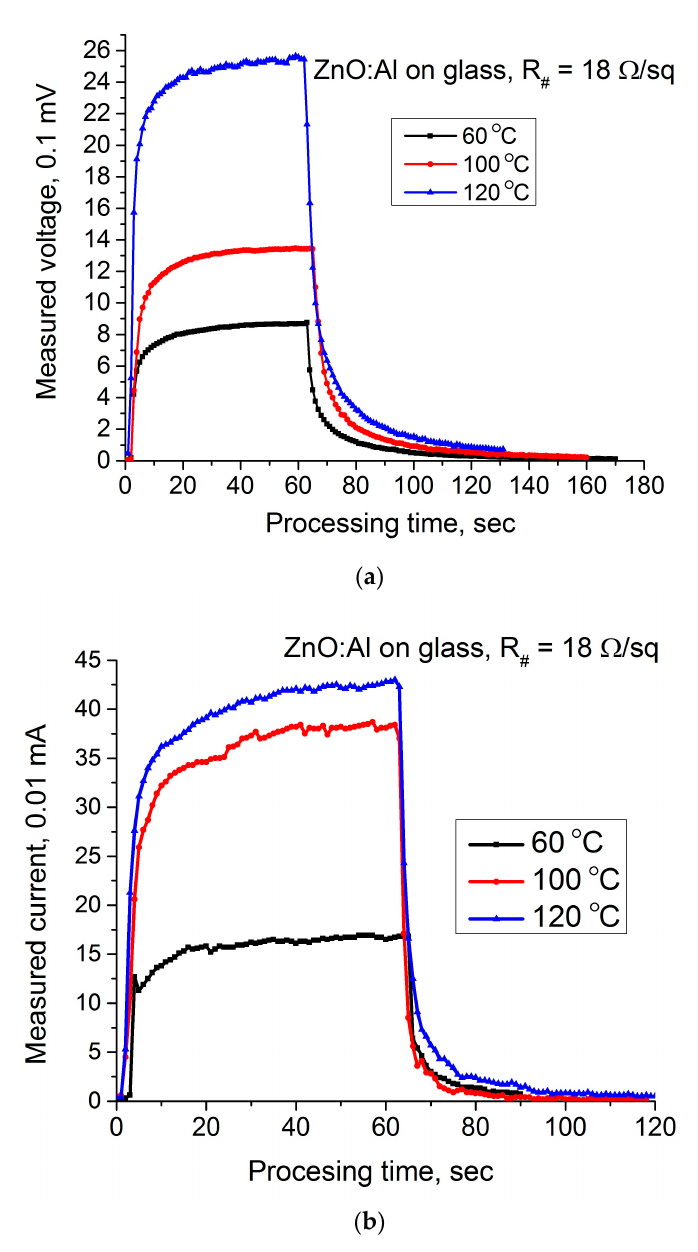
Figure 7. Dynamic hot-probe characteristics of the low-resistive AZO coatings: ( a ) a voltage measured between hot and cold electrodes; ( b ) a current between electrodes.